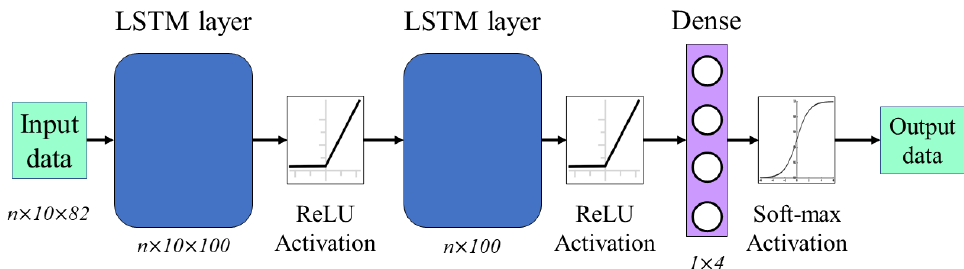
Figure 7. The architecture of the LSTM network implemented for the classification process, where n is the size of the input data